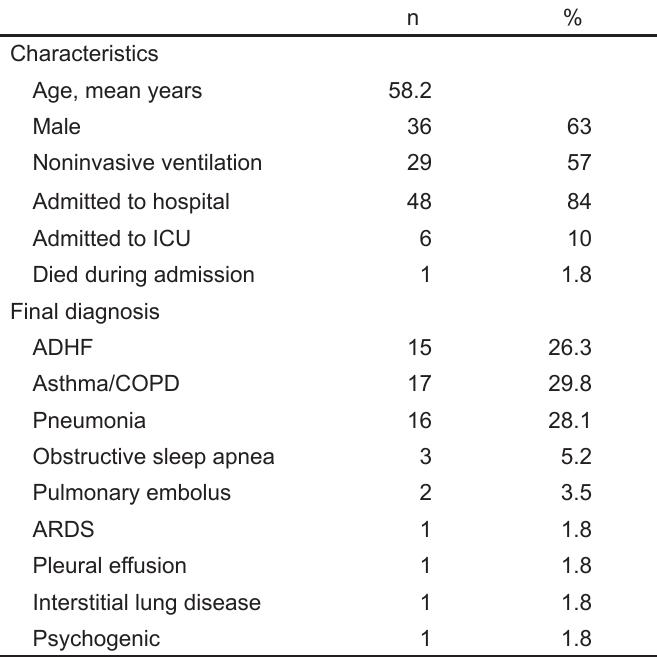
Table 1. Patient characteristics, clinical course and final diagnoses in a study evaluating utility of point-of-care ultrasound. Total N=57.